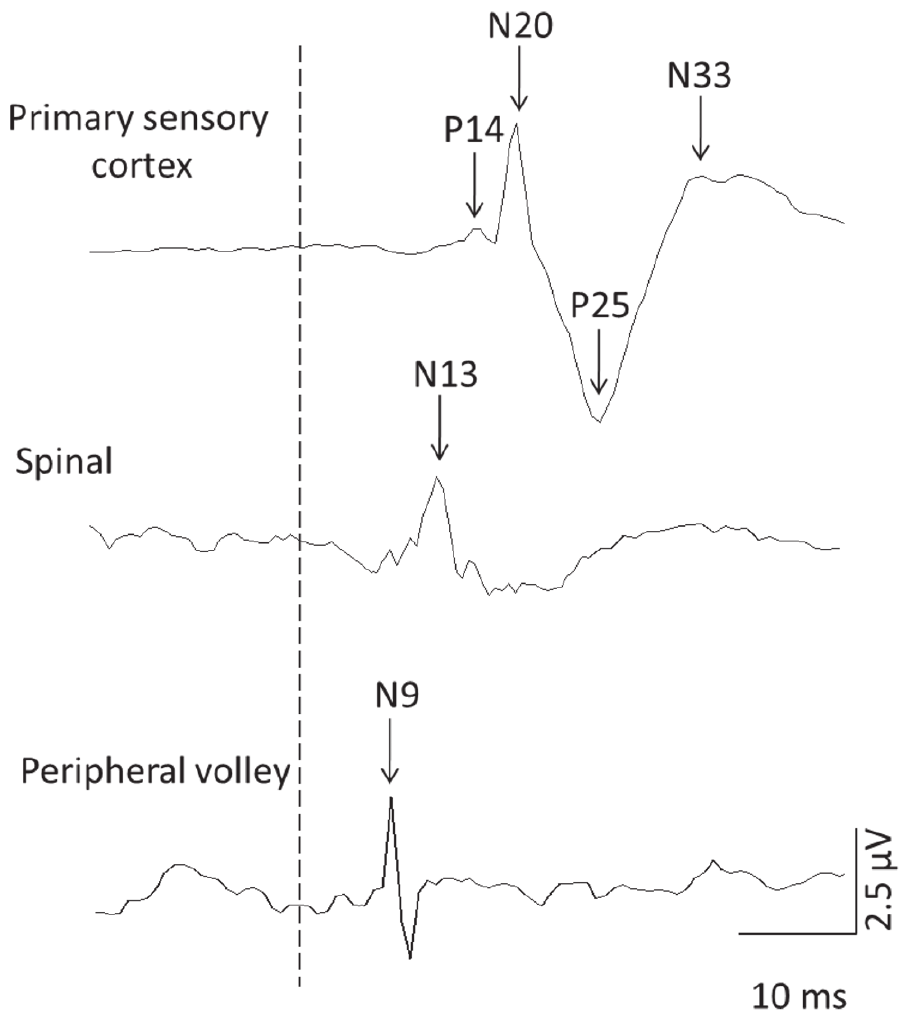
Figure 1. Raw data from a representative subject demonstrating the SEP components used for analysis of conduction and processing of the afferent volley at the primary sensory cortex, brainstem and the peripheral volley recorded at Erb’s point. The dotted line represents the time of stimulation.